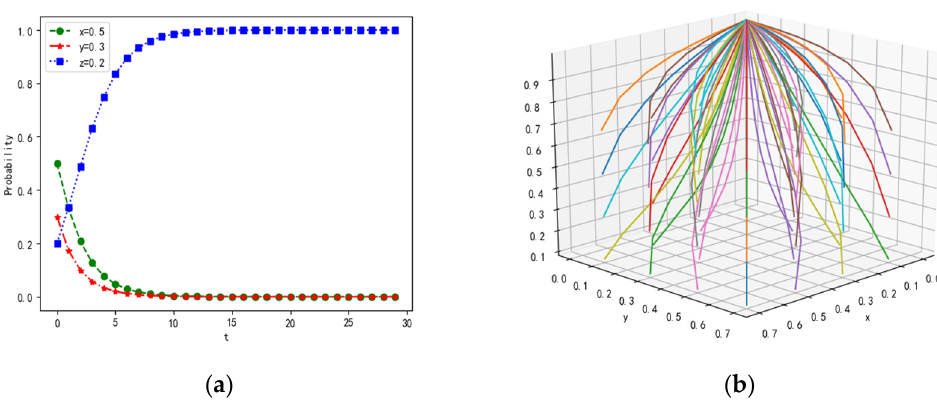
Figure 3. Evolutionary results of p 2 ( 0,0,1 ) shown under a corresponding constraint condition, ( a ) represents the conver- gence of probability with time, and ( b ) shows the results of dynamic simulation in three dimensions.